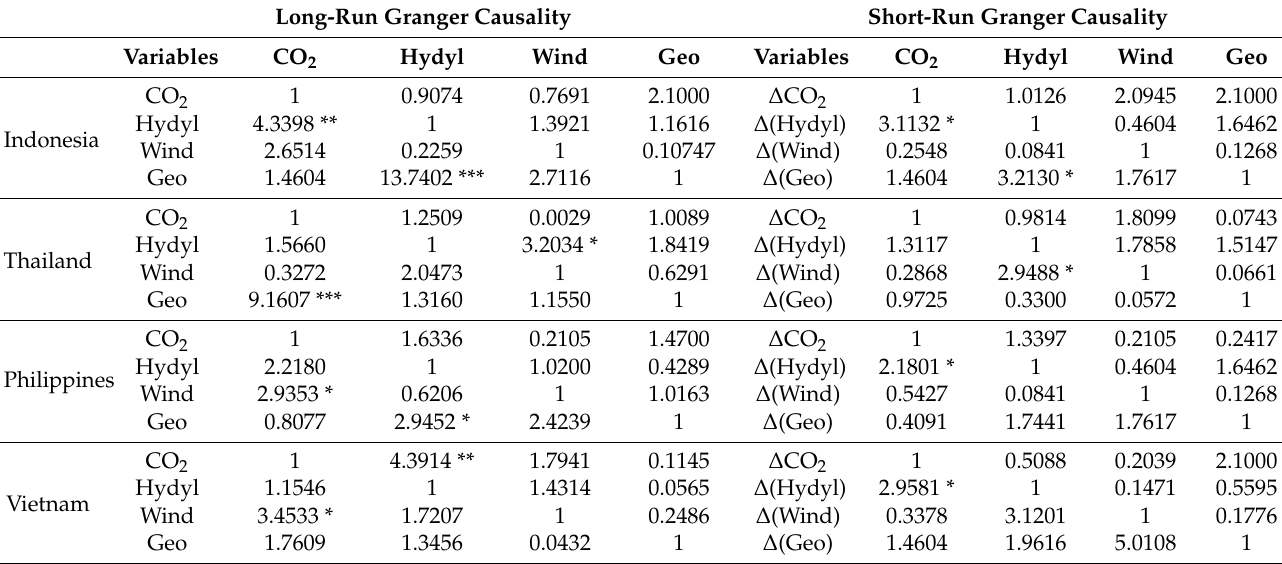
Table 9. Results of